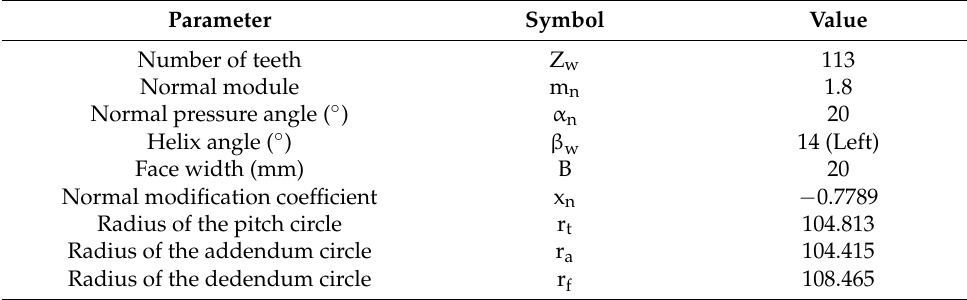
Table 1. Basic parameters of the work gear.